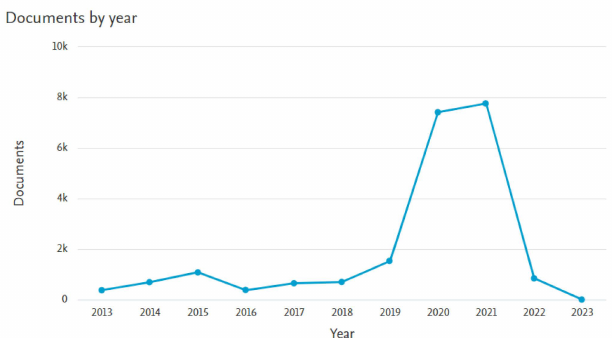
Figure 1. Trend of indexed publications related to agriculture robots based on search keywords “agriculture robot” and “agricultural robot” (data collected from Scopus and processed by authors).